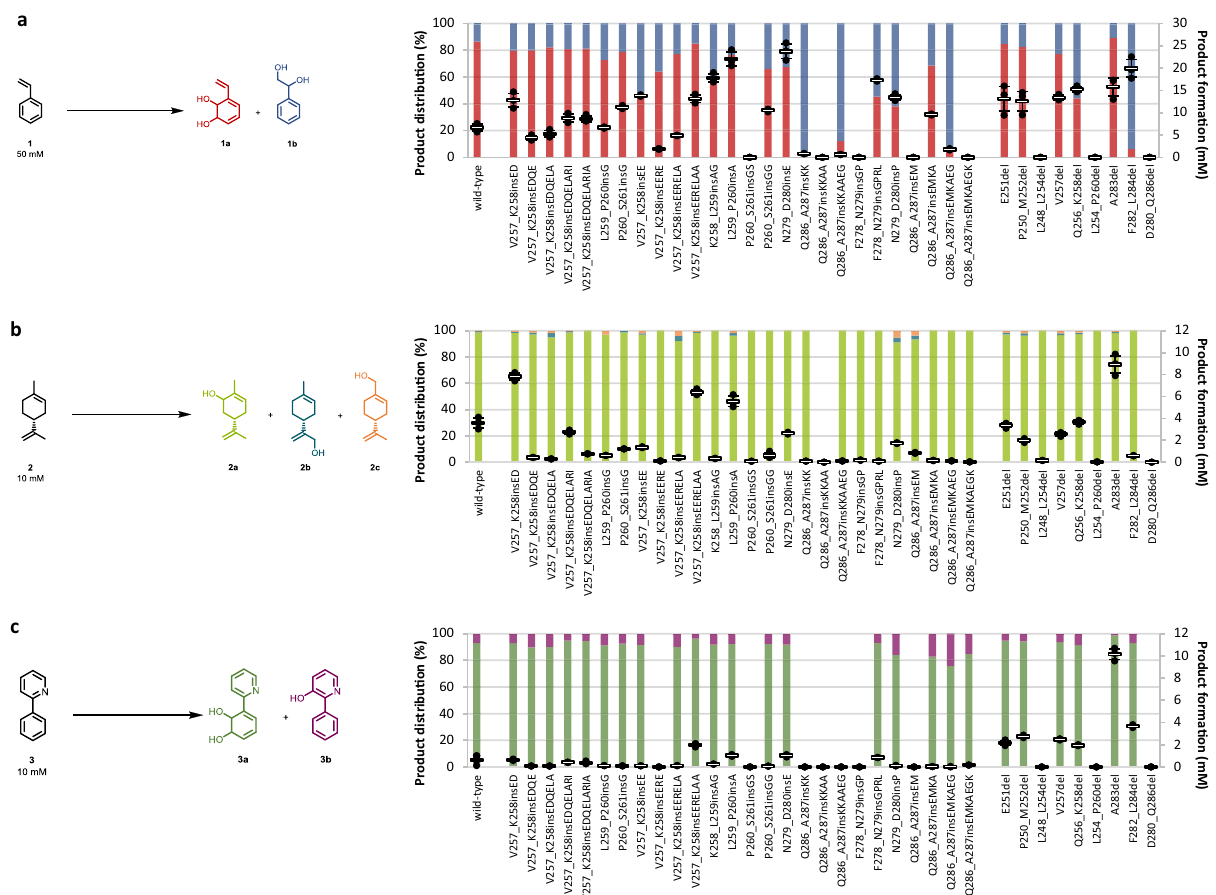
Fig. 3 Biotransformations with the wild-type, insertion and deletion variants. Insertion variants were derived from the sequence alignment with oxygenases from Phenylobacterium immobile E. a Product formation and distribution of the products 3-vinylcyclohexa-3,5-diene-1,2-diol 1a (VCHDD, red, bottom bars) and phenylethan-1,2-diol 1b (PED, blue, top bars) obtained during the biotransformation of styrene 1 . b Product formation and distribution of the products ( + )-carveol 2a (green, bottom bars), ( + )-mentha-1.8-dien-10-ol 2b (MDEO, blue, middle bars) and ( + )-perillyl alcohol 2c (orange, top bars) obtained during the biotransformation of ( R )-( + )-limonene 2 . c Product formation and distribution of the products 1,2-dihydroxy-3-(2 ’ -pyridyl) cyclohexa- 3,5-diene 3a (green, bottom bars) and 2-phenylpyridine-5-ol 3b (purple, top bars) obtained during the biotransformation of 2-phenylpyridine 3 . Reaction conditions and substrate concentrations are indicated in the reaction equation. The reactions were performed in technical triplicates (black dots) with average values (horizontal bar) and standard deviations (calculated using Excel version 2016) indicated. Error bars may be covered by markers. Source data are provided as a Source Data fi